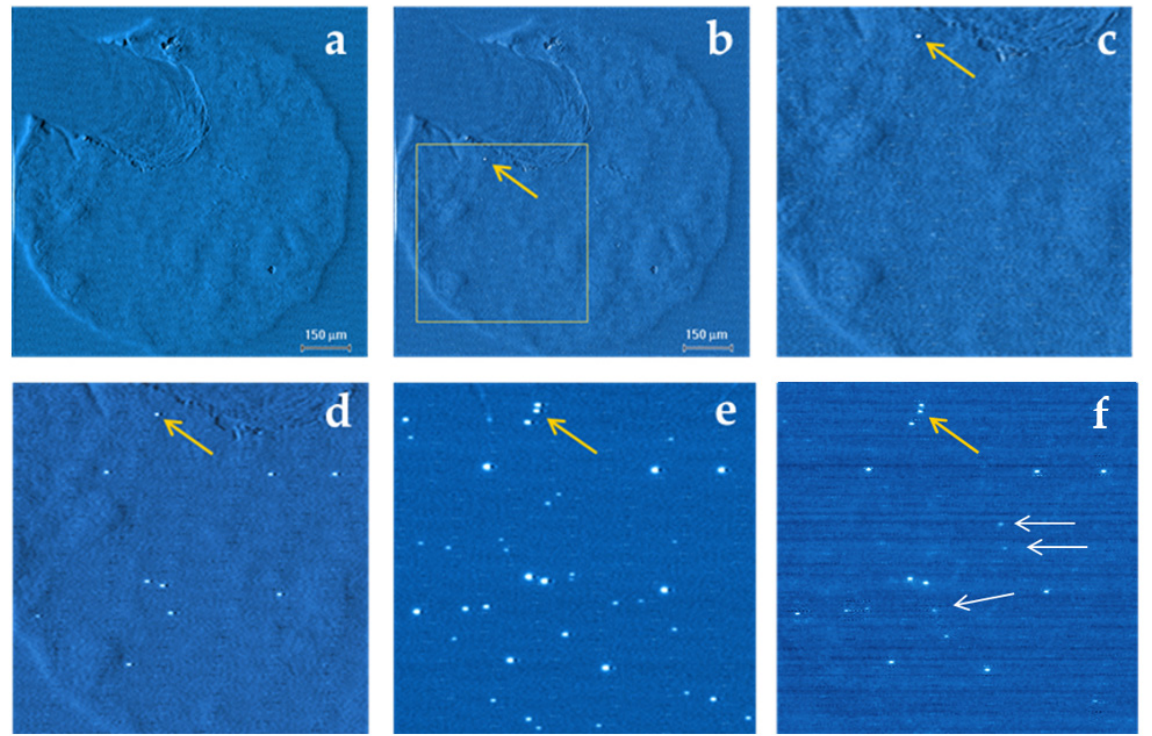
Figure 3. EBIC images obtained on Al/GO/n-Si MIS structures: pristine device ( a ); after Set voltage sweep of up to − 10 V ( b ); images of fragment marked as yellow square after Set voltage sweeps of up to − 10 V ( c ), − 15 V ( d ), − 25 V ( e ), and Reset voltage sweep of up to +15 V ( f ). Yellow arrows show location of the first-formed conductive channel; white arrows show new conductive channels formed during positive voltage sweep.